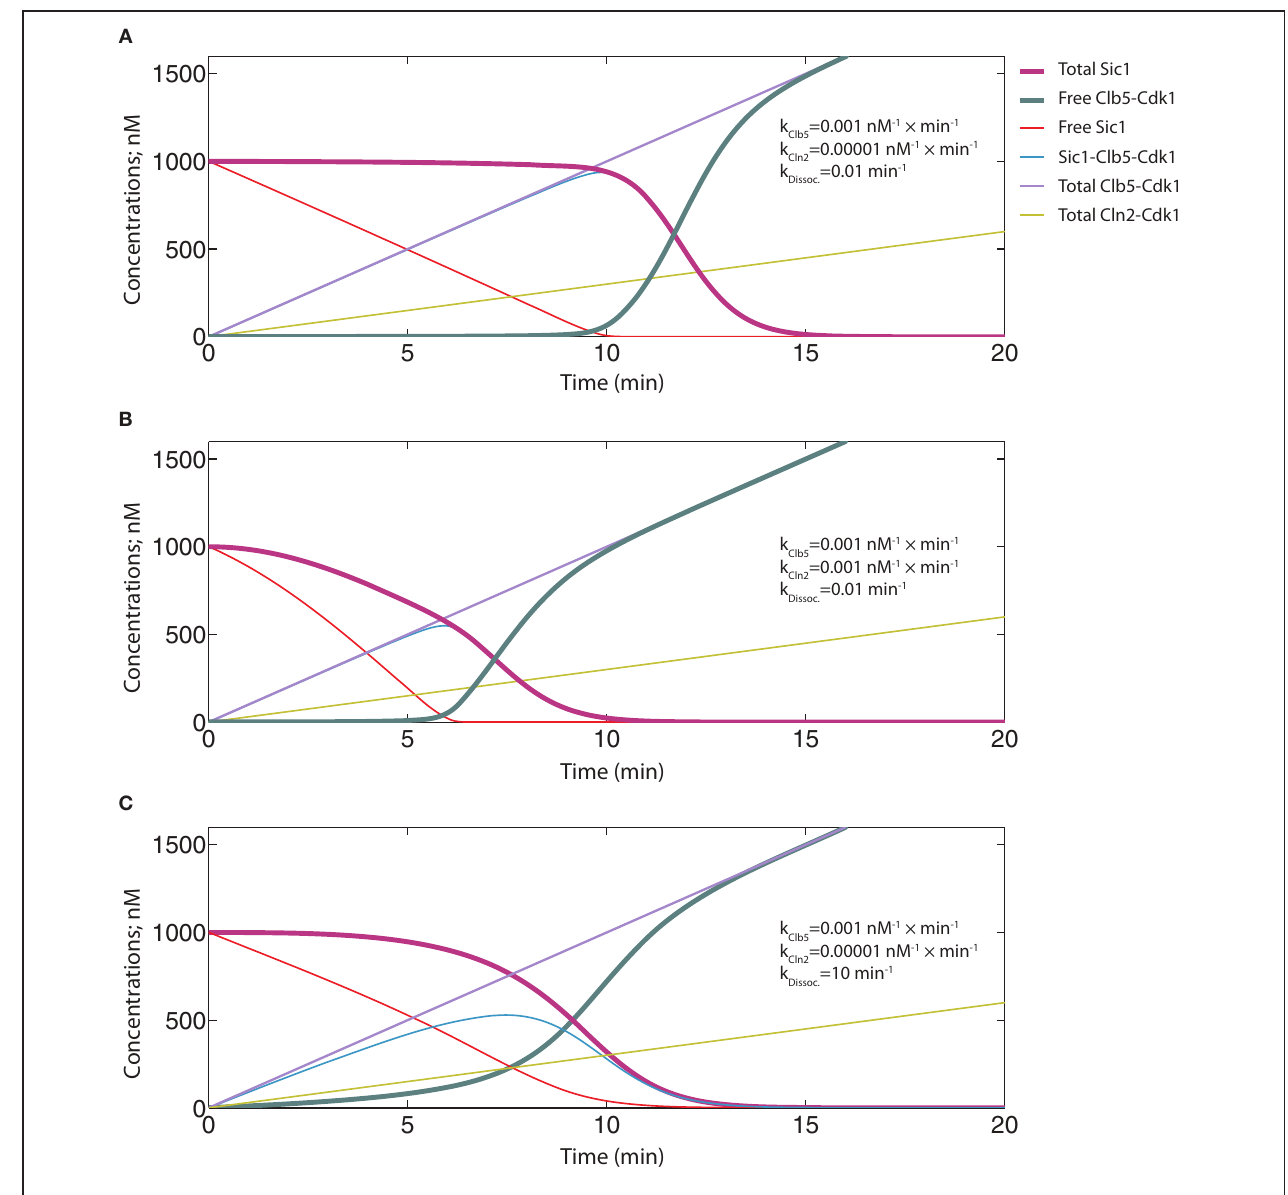
FIGURE 8 | Time course simulations to analyze the abruptness of the transition. The equation system and parameter values are provided in Table 2 . (A) The simulation with the basic set of key parameters for inhibition and phosphorylation, similar to those used in the phase diagrams in Figure 4 . (B) The effect of faster Cln2-dependent phosphorylation rate